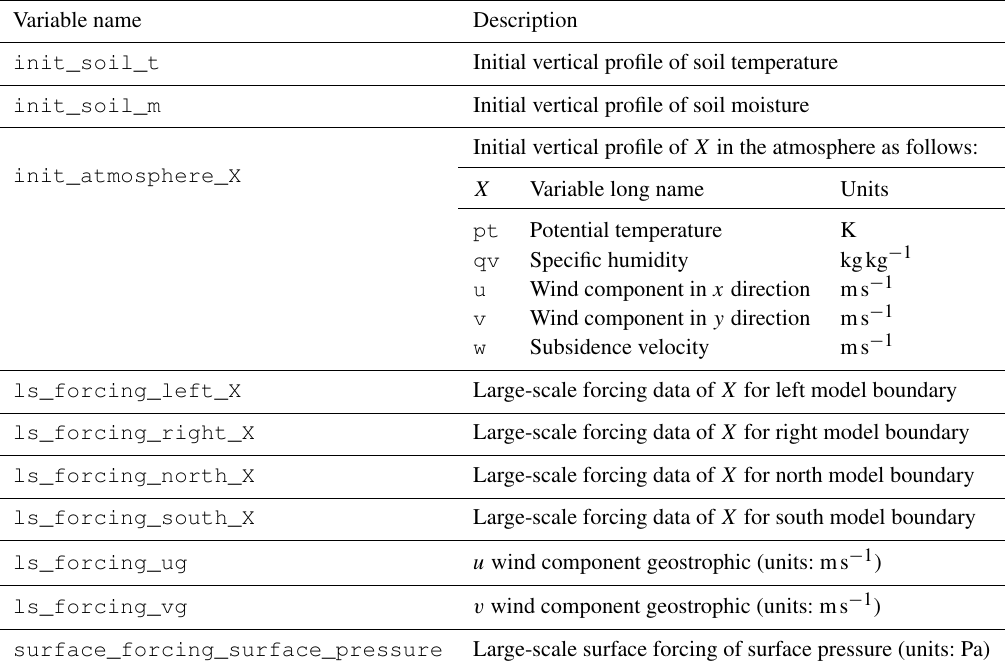
Table 1. Variables in the PALM dynamic driver based on PALM input data standard v1.9.